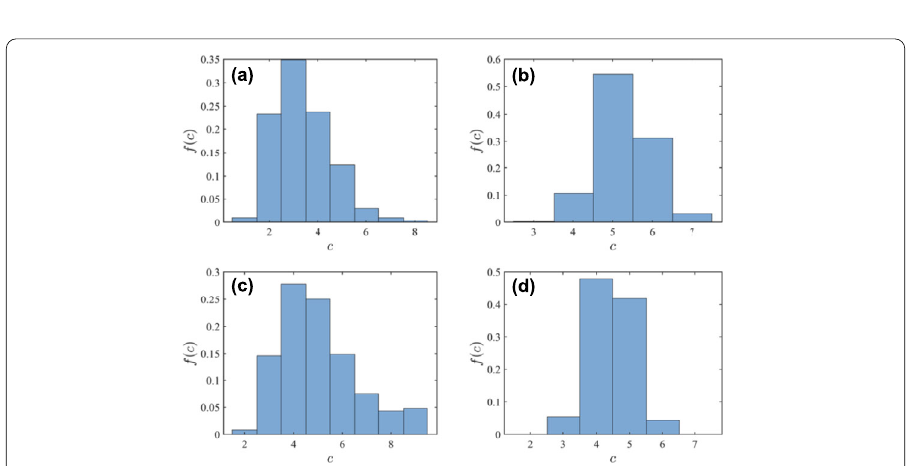
Figure 5 Plots of the percentage of the users who have the same number of layers in the SVEIN ( a ), ( b ) and SVCN ( c ), ( d ) based on the k -means ( a ), ( c ) and H / T ( b ), ( d ) break algorithm